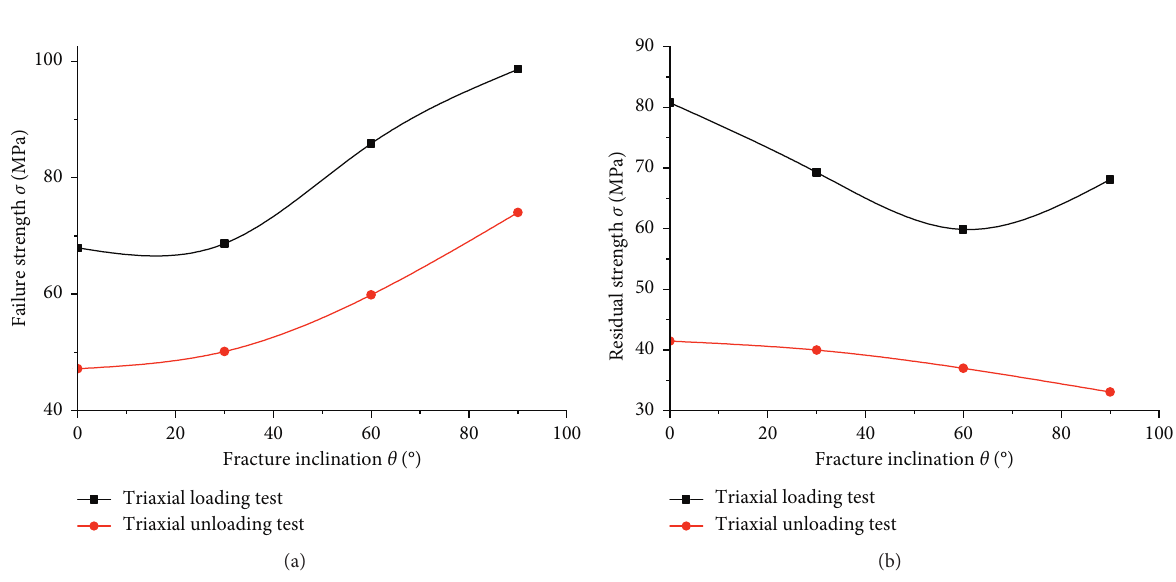
Figure 7: (a) Failure strength values and (b) residual strength values of the rock-like specimens with varying fissure inclinations under type I and II